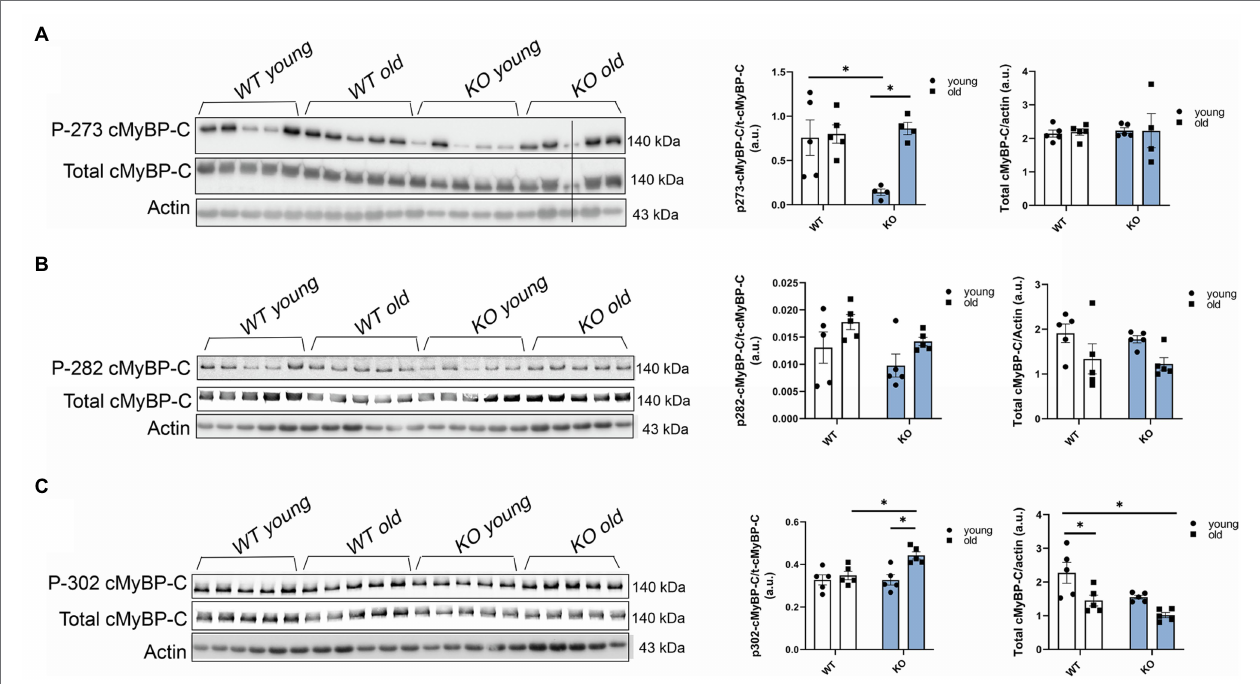
FIGURE 4 | Phosphorylation of cMyBP-C at Ser302 increases in aged KO mice. Western blot images showing phosphorylation of cMyBP-C at (A) Ser273, (B) Ser282, and (C) Ser302 with summarized quantification and actin as loading control. Third sample on the KO old group in (A) was excluded from analyses due to loading problems as indicated with vertical black line drew across bands. t-cMyBP-C: total cMyBP-C. Young: 3–6 months and old: 12–16 months. Data presented as mean ± SEM. N = 4–5. Outliers were identified with the ROUT method and excluded from analyses. Data analyzed with a two-way ANOVA post-hoc Fisher’s LSD test. * p <